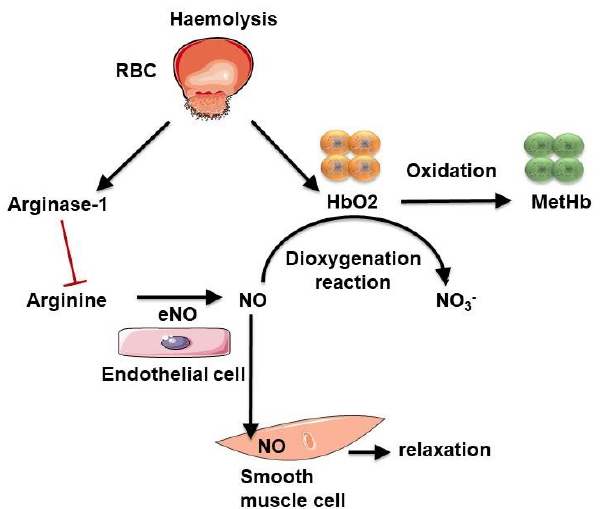
Figure 7. Influence of haemolysis on nitric oxide (NO) bioavailability. Intravascular haemolysis induces arginase-1 and haemoglobin release. Arginase-1 produces ornithine from arginine, the required substrate for NO production. Oxygenated haemoglobin (HbO2) can scavenge NO by a dioxygenation reaction, producing inert nitrate and methemoglobin (MetHb). These two reactions decrease NO bioavailability.